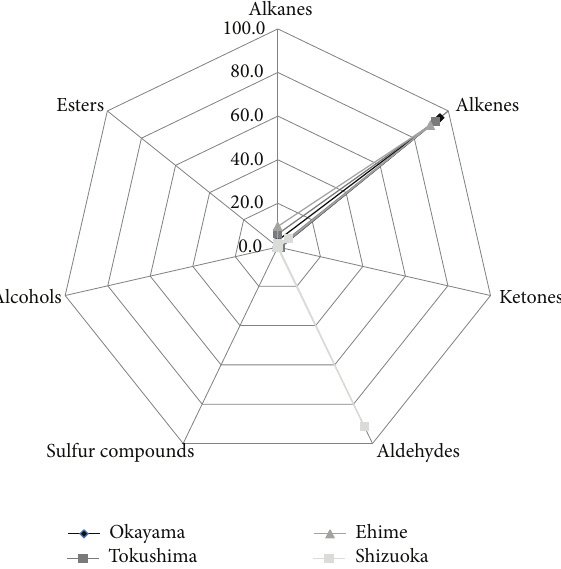
Figure 3: Chemical classification of volatile compounds in relative concentrations ( 𝑛 = 3 ) in different commercial green algae samples.